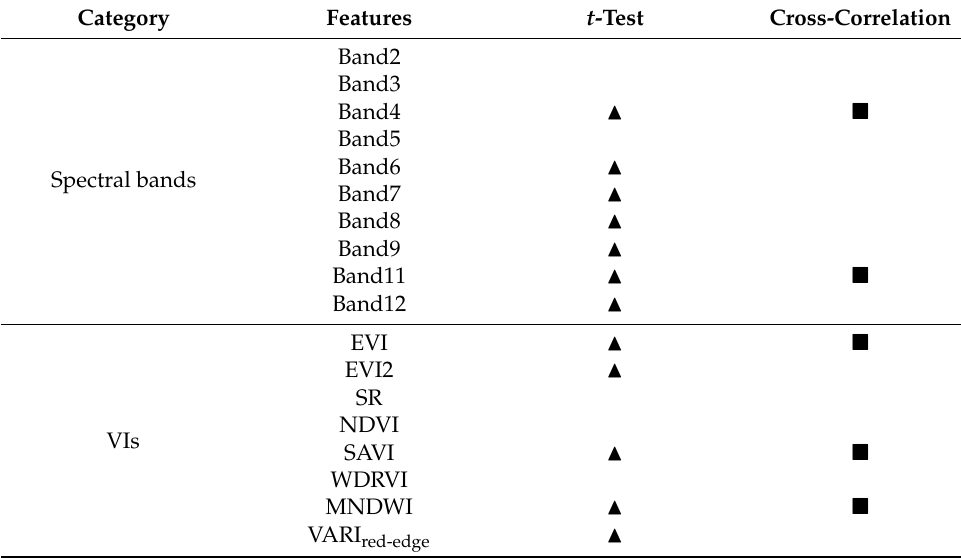
Table 3. Results of sensitivity analysis with the single-scene Sentinel-2 image.